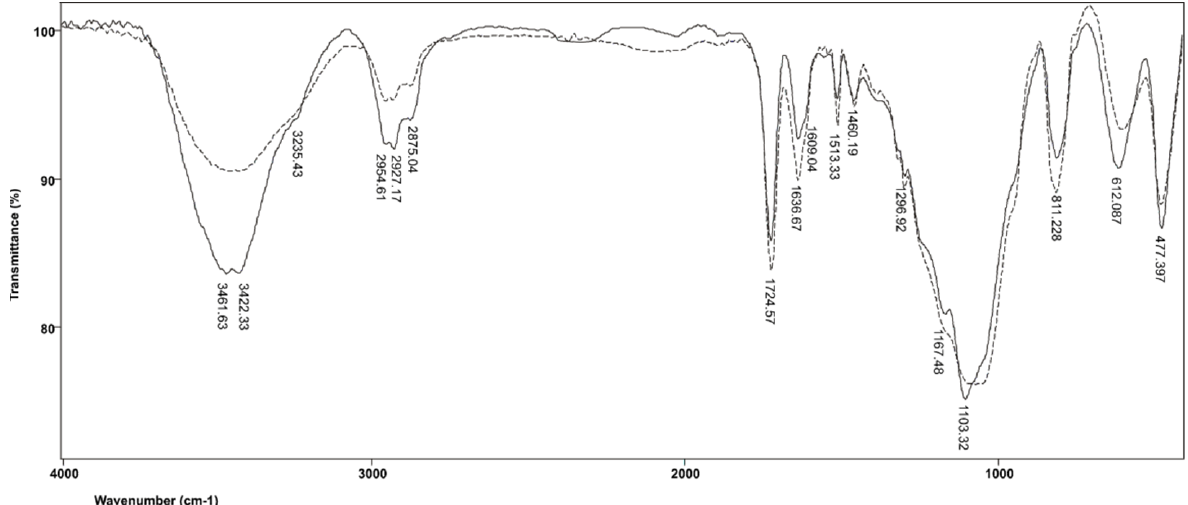
Figure 3. FTIR spectrum produced by the RelyX ARC resin before and after polymerization.